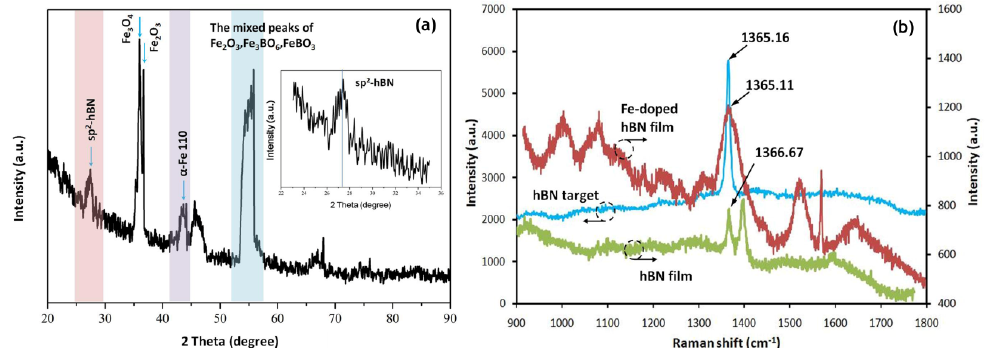
Figure 3. The ( a ) XRD patterns and ( b ) Raman spectra of Fe − doped hBN film.